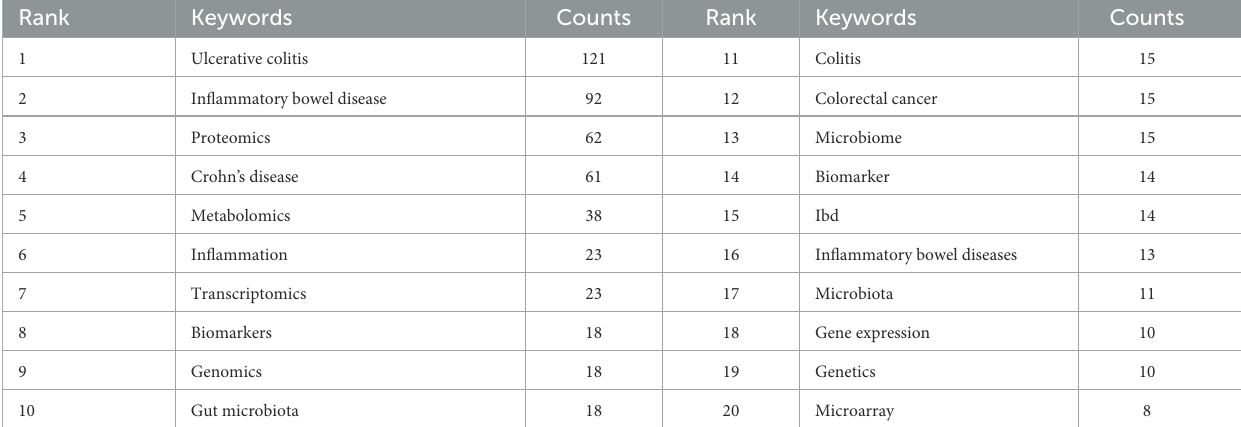
TABLE 5 The top 20 keywords on the research of omics in